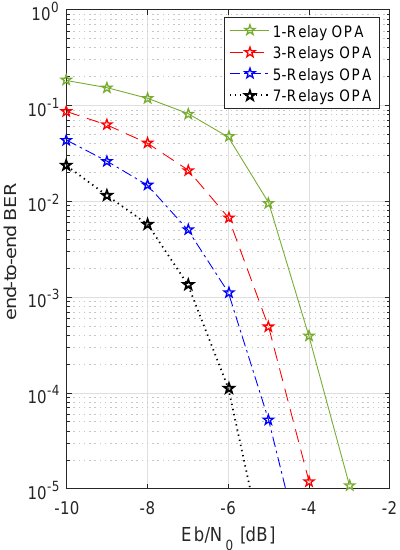
Figure 11. OPA: BER of system with multiple relays, codeword length = 312, m 1 = m 2 = 3, 4-QAM, and varying code rates C R .